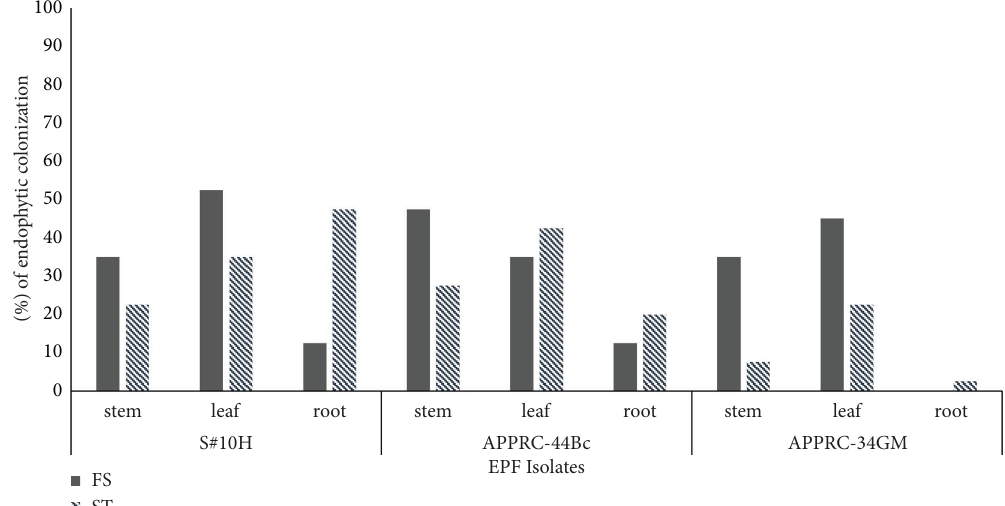
Figure 2: Percent colonisation of e ntomopathogenic fungi (EPF) strains using foliar spray method and seed treatment; FS: foliar spray, ST: seed treatment.